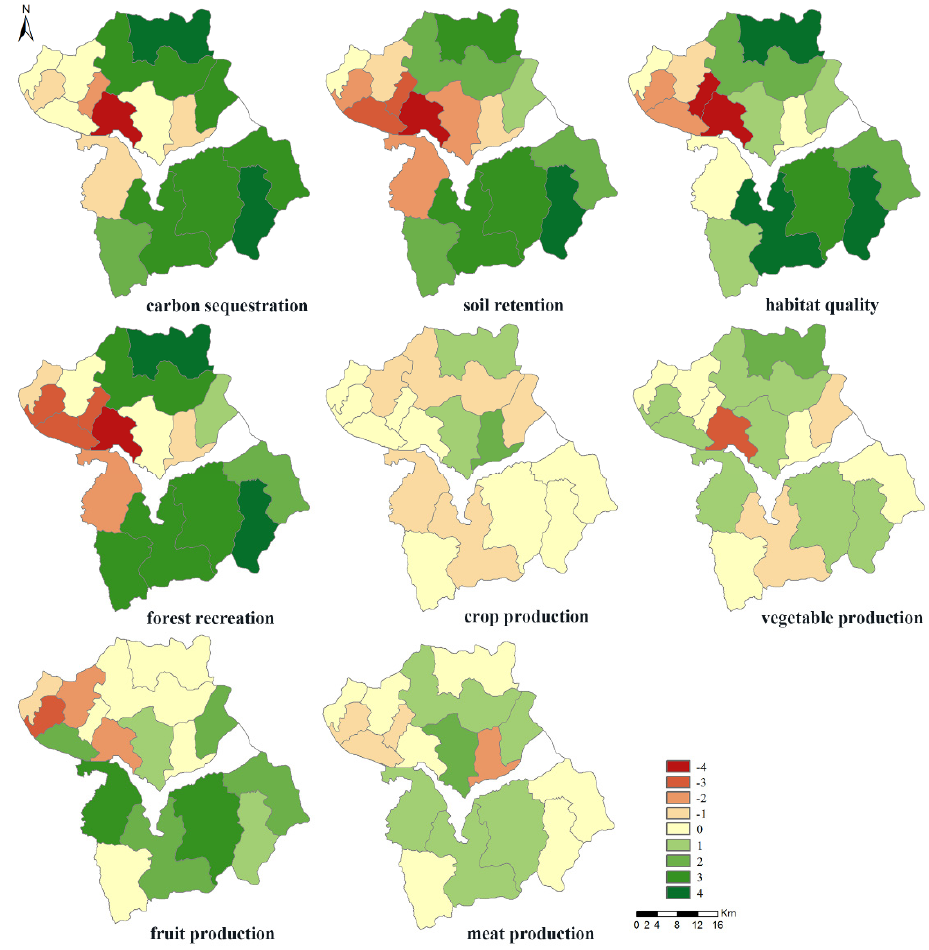
Figure 7. Spatial distribution of ES supply–demand relations in Huailai